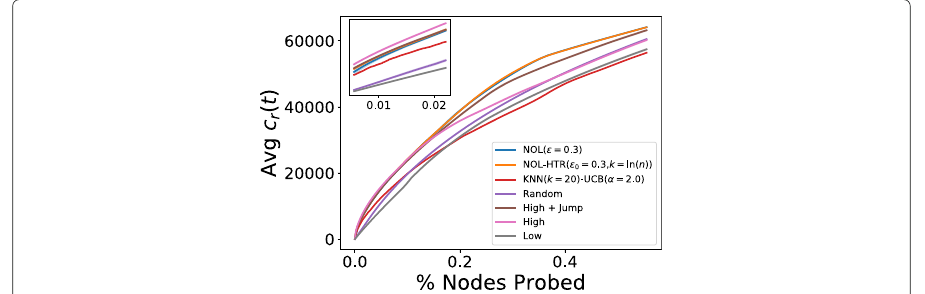
Fig. 4 Cumulative reward results on a Twitter social network constructed from mutual interactions. The budget in the experiment was 50k queries. Twitter data is typically collected via repeated API access, so represents a natural use case for NOL-HTR. Inset: Magnification showing that NOL-HTR and the high degree baseline methods outperform NOL in the first few thousand probes of the